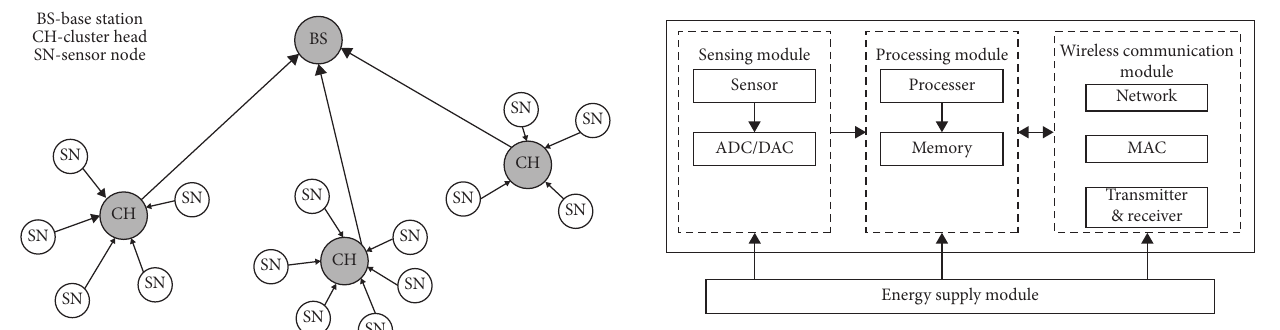
Figure 4: Block diagram of the sensor node model.